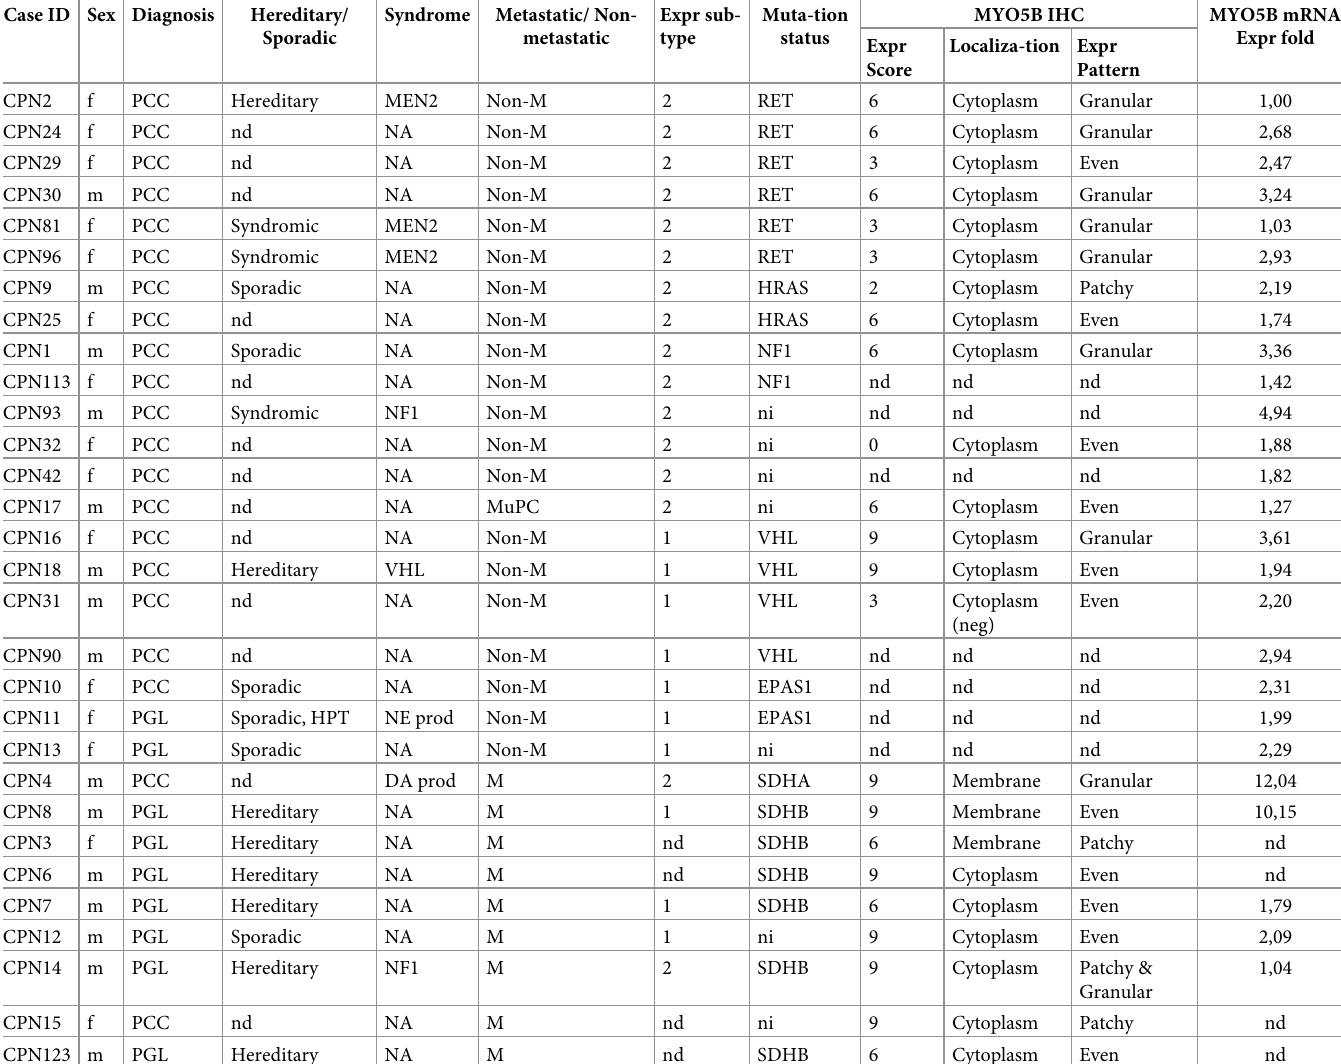
Table 1. Patient data, mutation status, and MYO5B